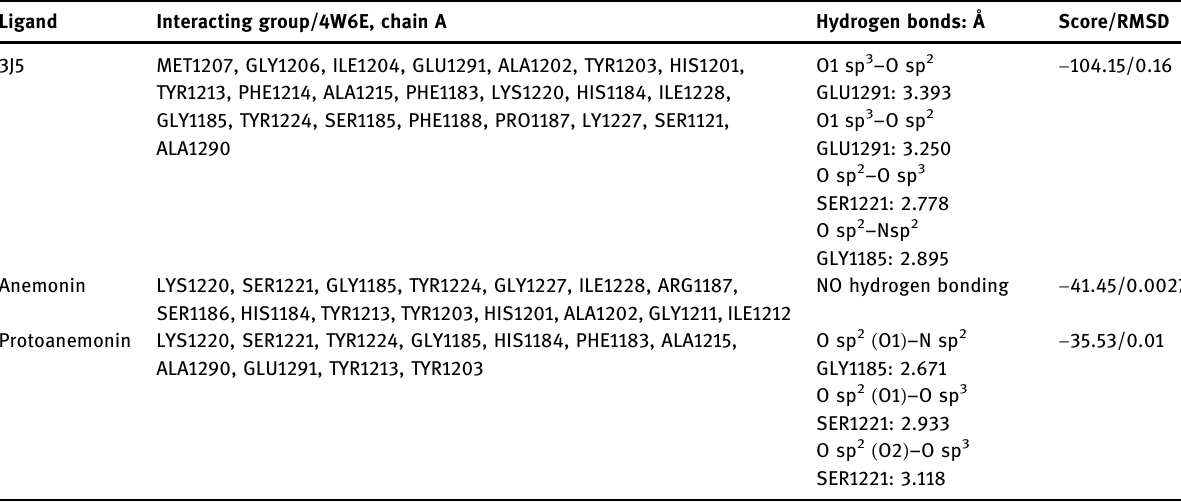
Table 3: Results of molecular docking study on human tankyrase 1, TNKS1 Ligand Interacting group/4W6E, chain